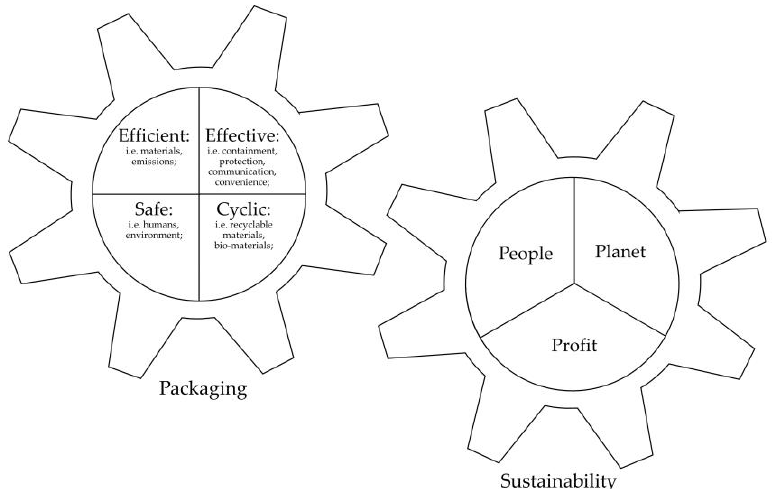
Figure 1. Principles of sustainable packaging and their impact on ecological, economic and social sustainability. Graphic based on [42,43,46].